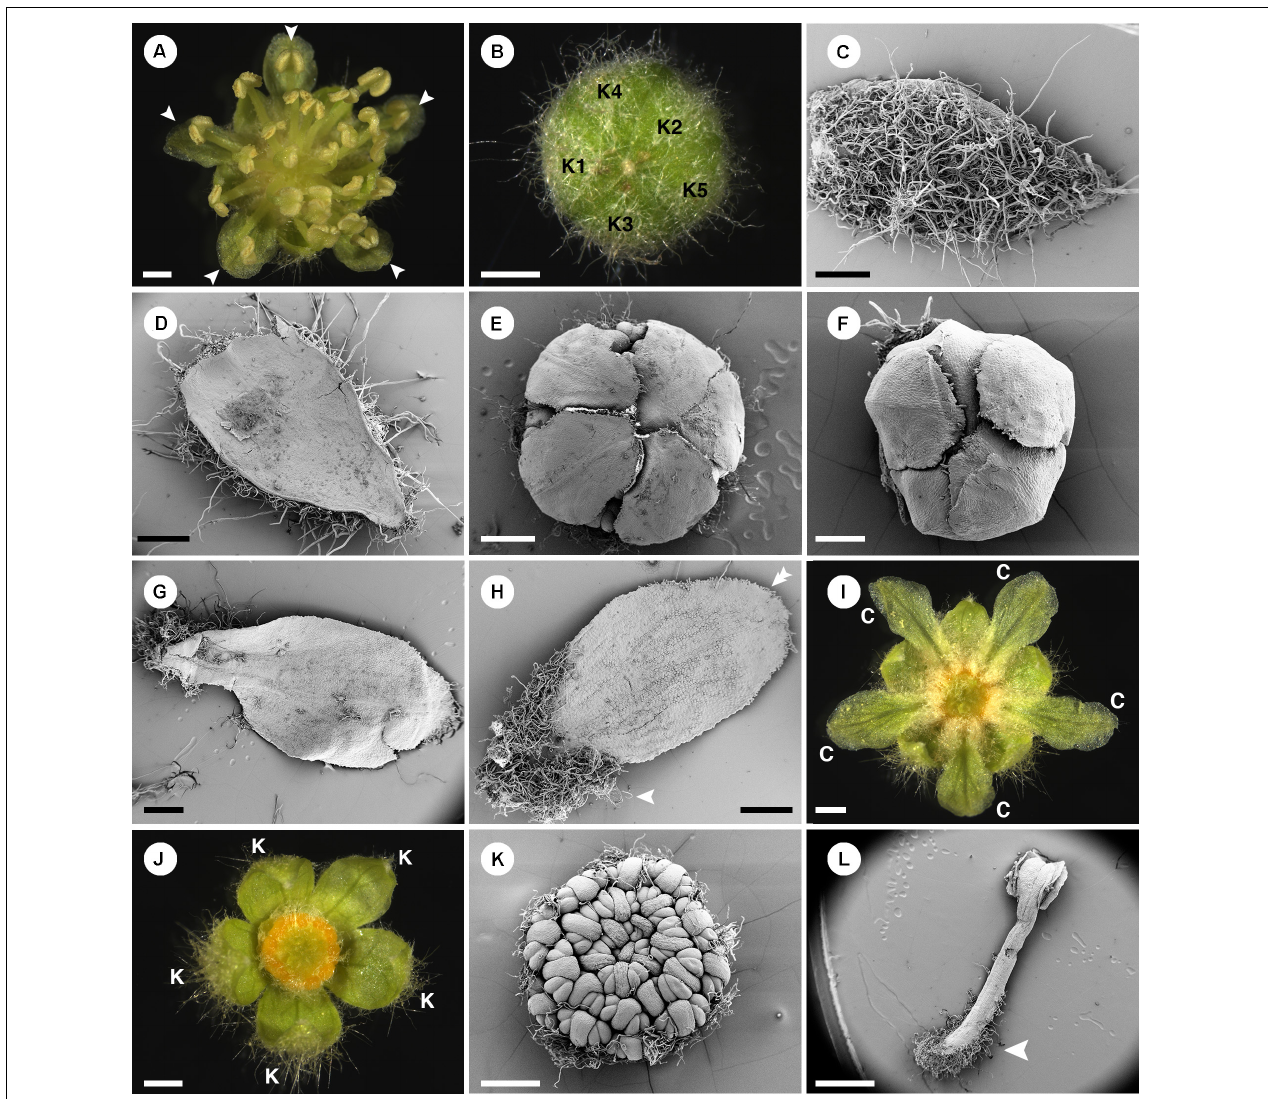
FIGURE 3 | Morphology of staminate flowers of Croton chilensis . (A) Anthetic flower. Note, the outermost stamens are opposite petals (arrowhead). (B) A flower bud near anthesis with quincuncial aestivation. (C) Abaxial surface of a sepal covered with long stellate trichomes. (D) Adaxial surface of a sepal with glabrous surface. (E) Corolla with cochlear aestivation. (F) Corolla with quincuncial aestivation. (G) Abaxial surface of a petal with few stellate trichomes on the surface. (H) Adaxial surface of a petal with long simple trichomes covering the lower part (arrowhead). Note, there are papillae on the margin of the apex (double arrowhead). (I) A flower with stamens removed showing trichomes on the lower part of the petals covering nectary glands. (J) A flower with petals and stamens removed showing multiple yellow nectary lobes. (K) Flower bud with young androecium, perianth removed. Note, anthers are inflexed making them look like facing outward. (L) A stamen with lower part of filament covered with many simple trichomes (arrowhead). K, sepal; C, petal. Scale bars: (A,B,I,J,L) = 1,000 µ m; (C–E,G,H,K) = 500 µ m; (F) = 200 µ